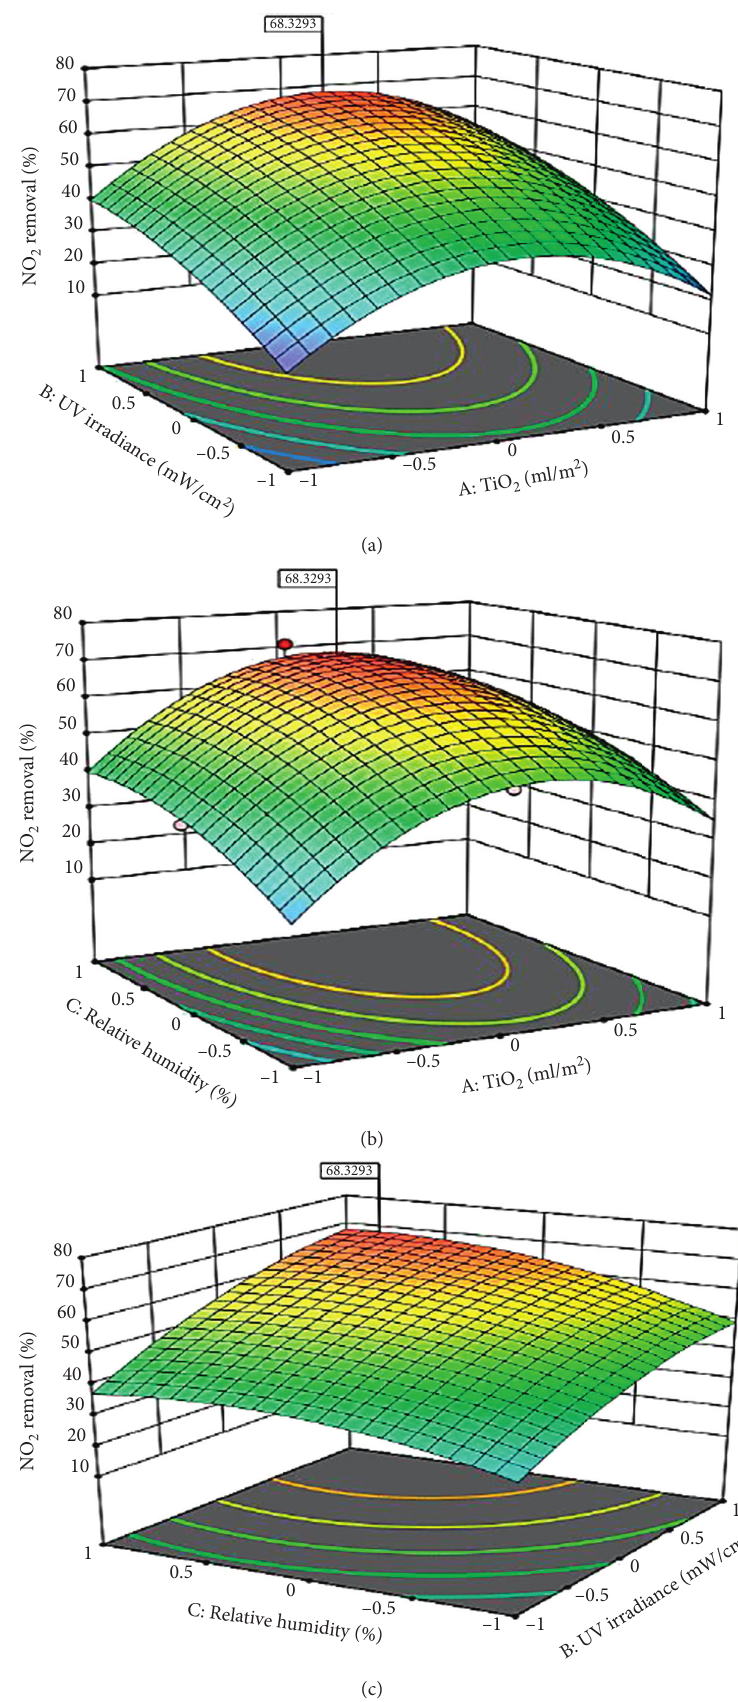
Figure 5: Response surface